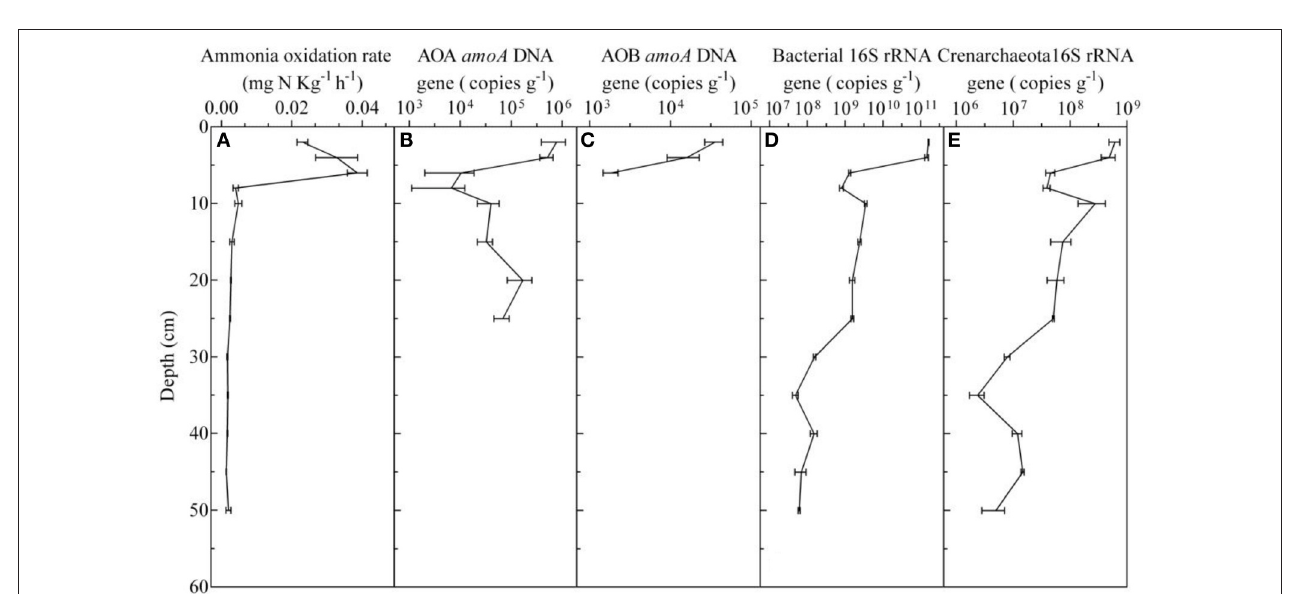
FIGURE 3 | Vertical distribution of ammonia oxidation activity (A), AOA amoA gene (B), AOB amoA gene (C), and bacterial (D) and crenarchaeota (E) 16S rRNA gene copy numbers in the sediment cores, which was detected in October 2014.